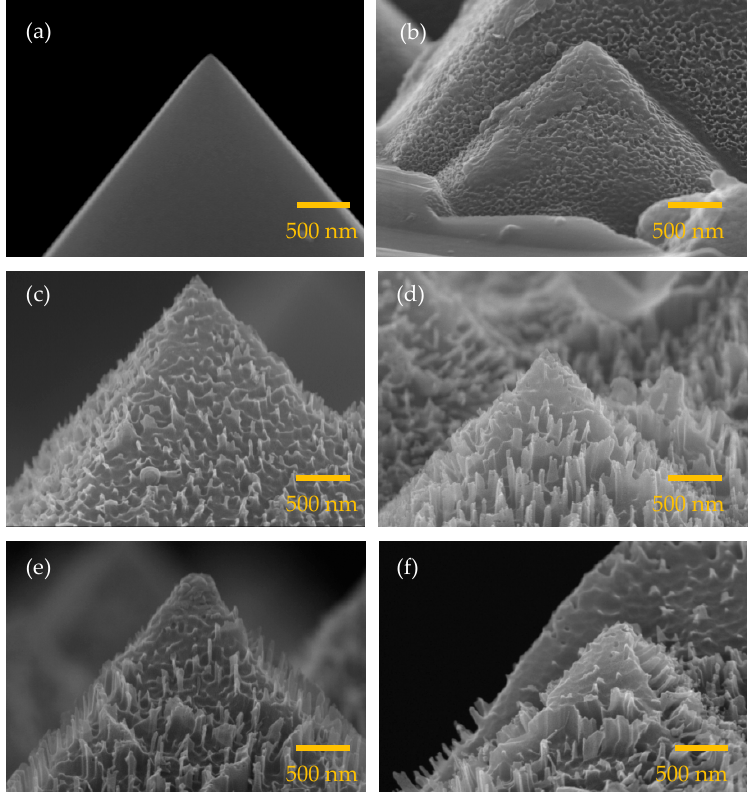
Figure 2. Scanning electron microscope (SEM) images for the alkaline-etched silicon wafers with the metal-assisted chemical etching (MACE) process for ( a ) 0, ( b ) 1, ( c ) 3, ( d ) 5, ( e ) 7, and ( f ) 9 min.